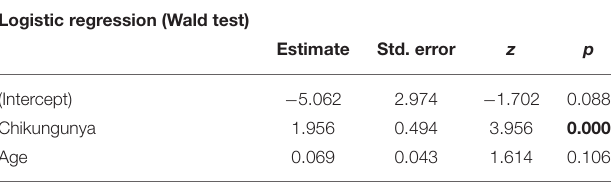
TABLE 3 | Estimated coefficients for the logistic regression that models the probability of deficient performance on the MoCA test as a function of chikungunya infection and the participant’s age.